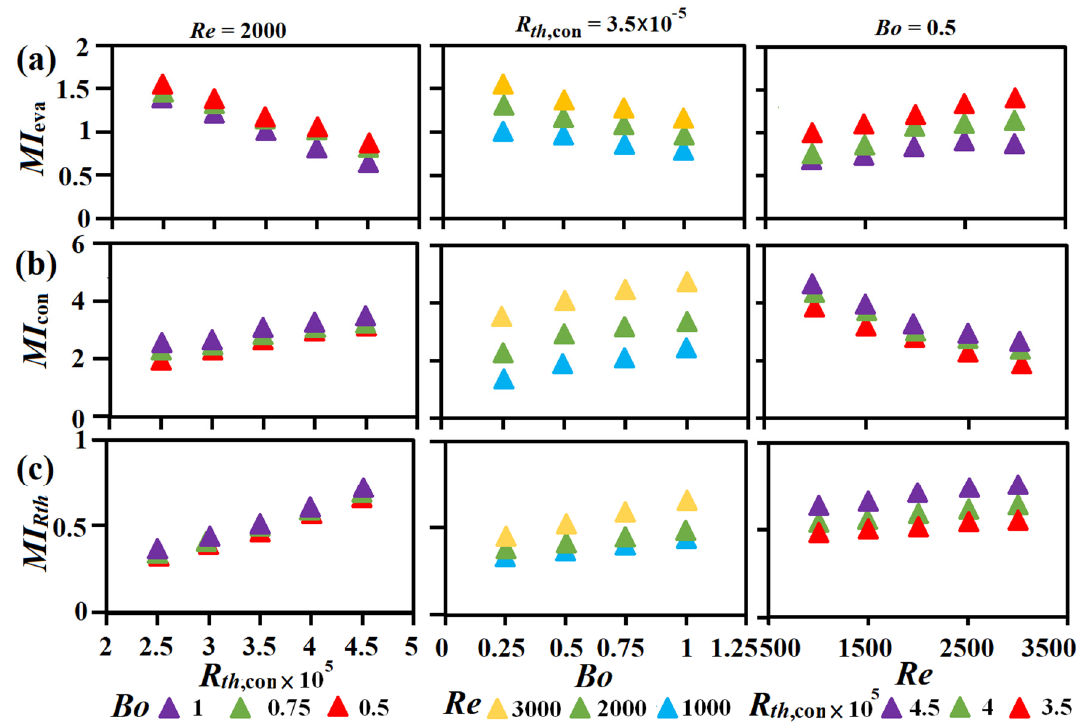
Figure 12. Variations of (a) MI eva (b) MI con (c) MI Rth with R th ,con , Bo , and Re .